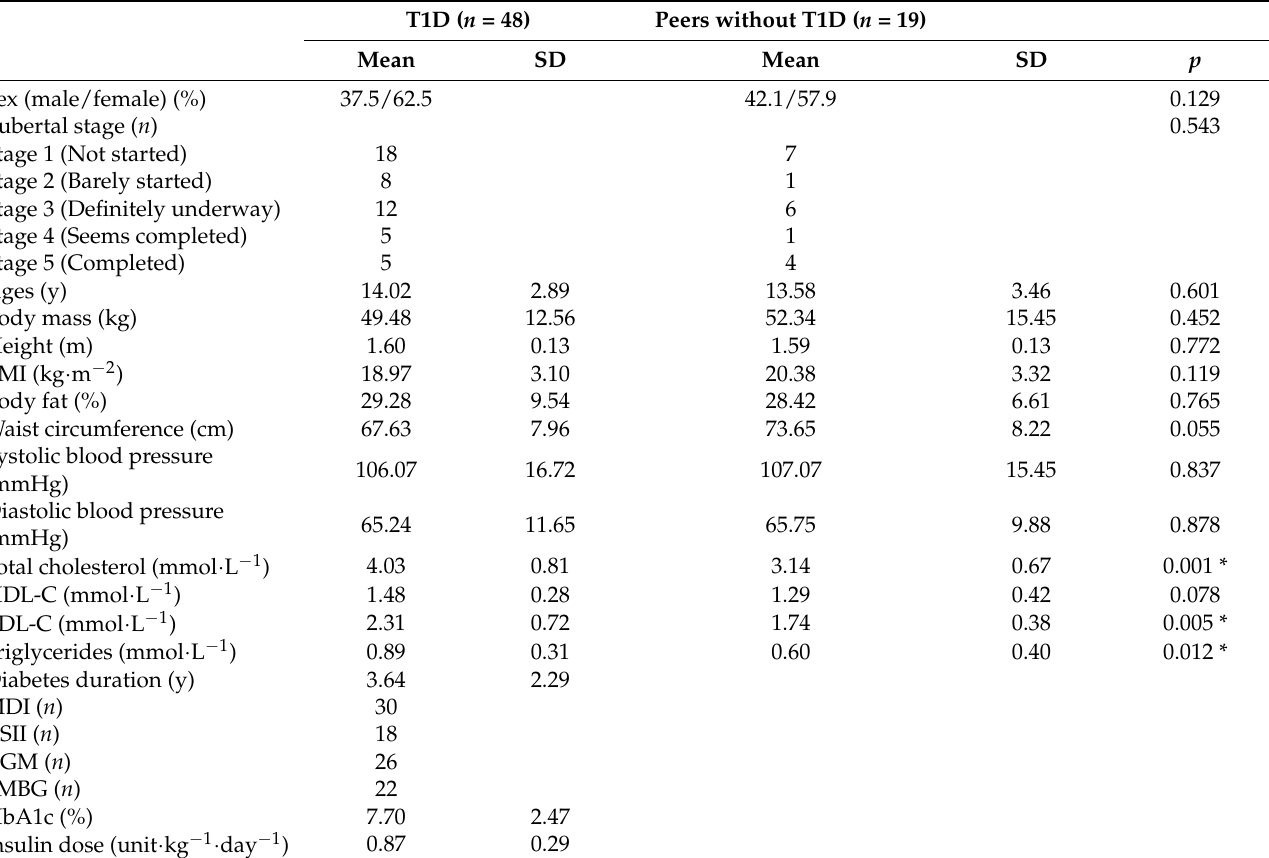
Table 1. Comparison of descriptive data between adolescents with T1D and peers without diabetes. T1D ( n = 48) Peers without T1D ( n = 19) Mean SD